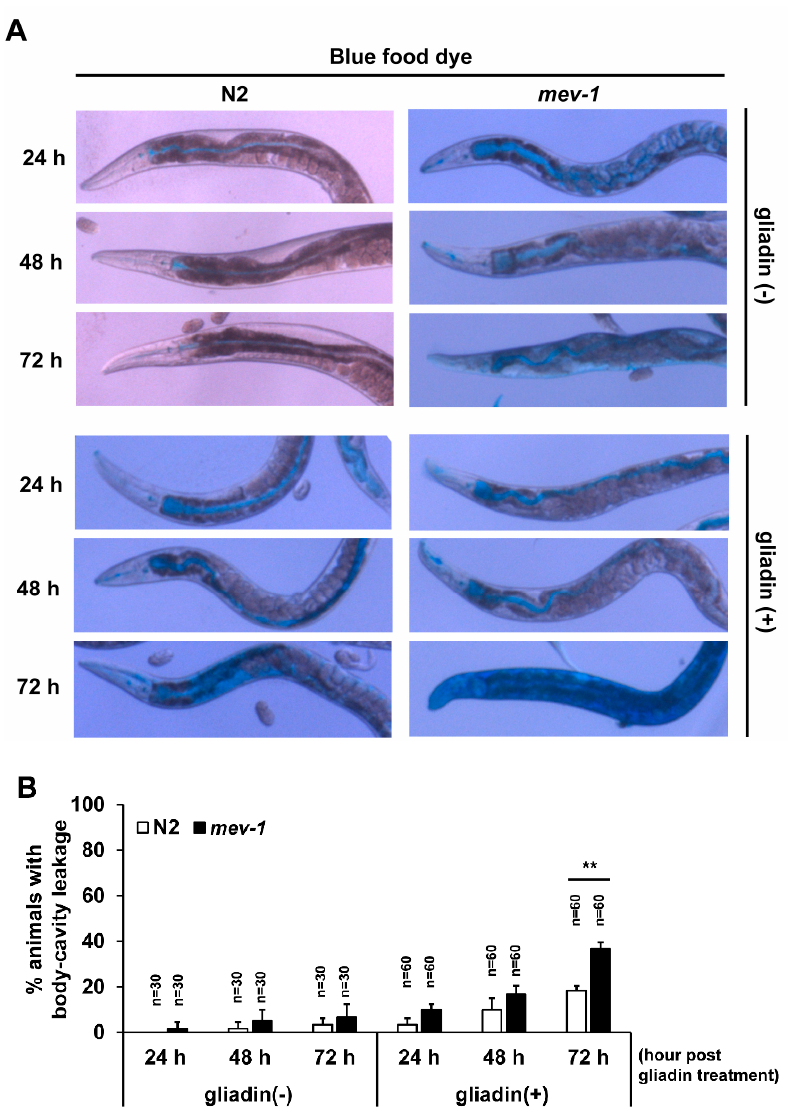
Figure 5. E ff ects of gliadin treatment and age on intestinal barrier function in wild-type N2 and mev-1 mutant C. elegans worms. ( A , B ) Wild-type N2 and mev-1 mutants synchronized at the L4 larval stage were treated with or without gliadin then soaked in blue food dye for 3 h on respective hours of gliadin treatment at adulthood. Di ff erential interference contrast (DIC) images of wild-type N2 and mev-1 mutants ( A ) after soaking in blue food dye for 3 h after the indicated hours of gliadin treatment. Quantification of body-cavity leakage in wild-type N2 and mev-1 mutants ( B ) after indicated lengths of gliadin treatment during adulthood. Error bars represent s.d. ** p < 0.005 (Student’s t -test).